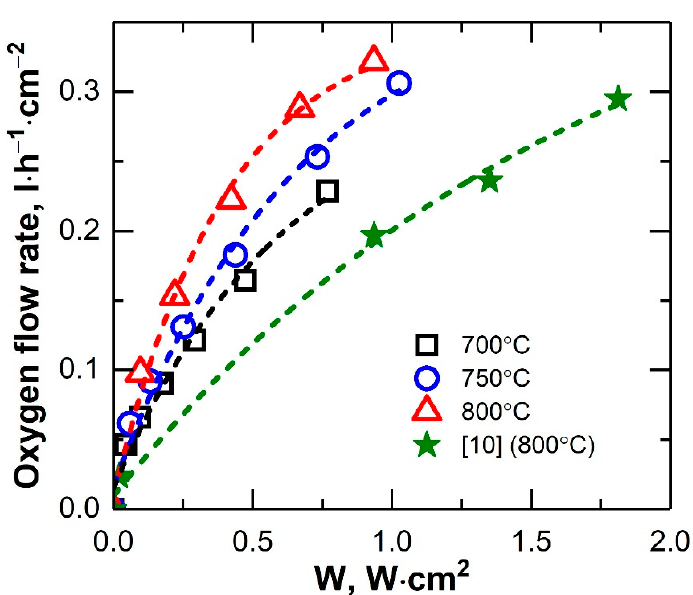
Figure 10. Current–voltage performance of the microtubular oxygen pump.